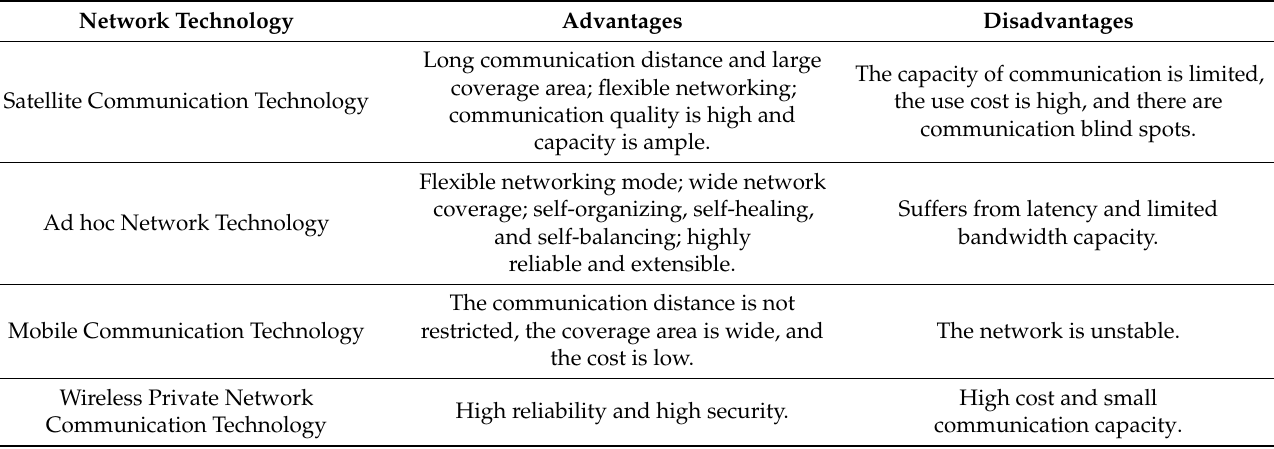
Table 3. Advantages and disadvantages of different network